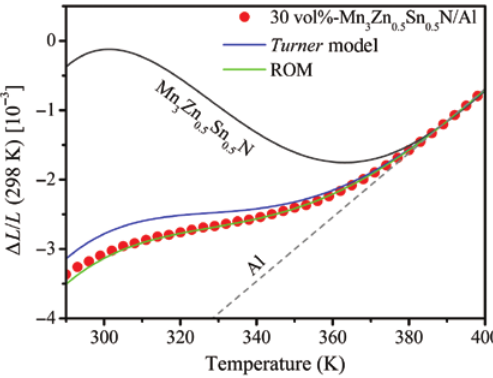
Figure 6: Experimental plots of thermal expansion as well as curves calculated by assuming ROM and Turner ’s model for 30 vol.%- Mn Zn Sn N/Al 3 0.5 0.5